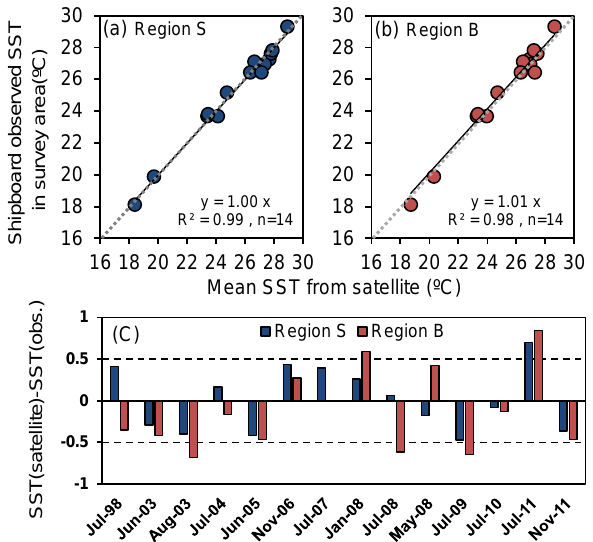
Figure 2. Linear regression relationships between areal mean AVHRR SST in two model regions, i.e., (a) S and (b) B; and field observed areal mean SST in cruise survey area (dashed line is 1 : 1 reference line). (c) Differences between the calibrated satellite data and shipboard-observed SST from 1998 to